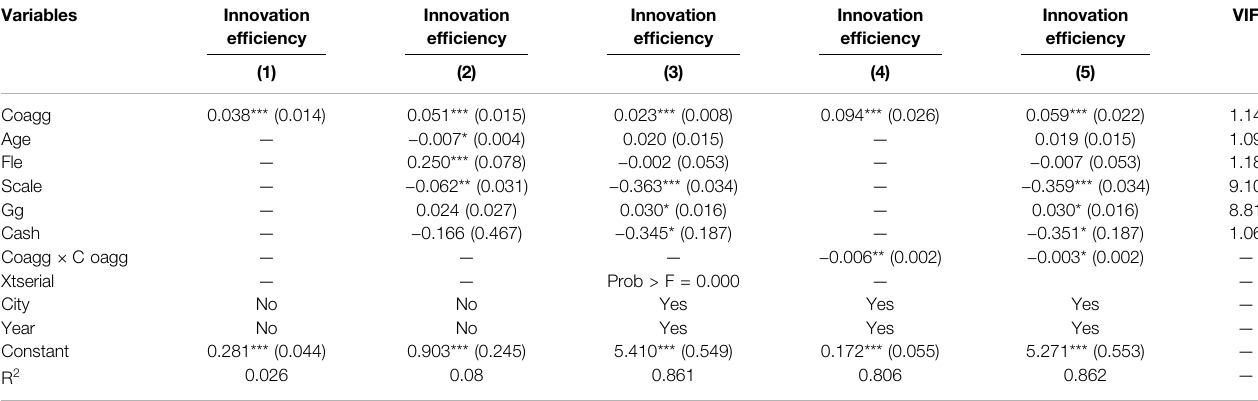
TABLE 2 | Results of